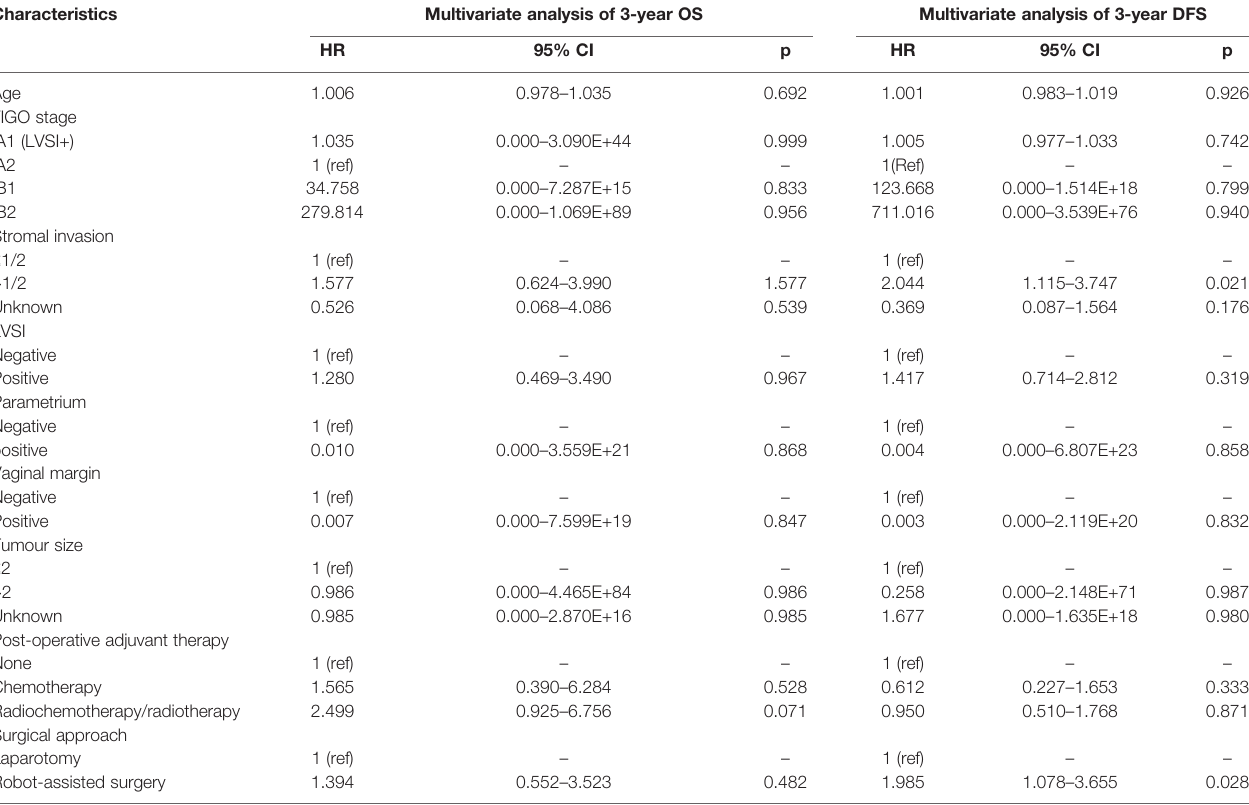
TABLE 2 | Cox multivariate analysis of the relationship between the surgical approach and OS and DFS in cervical cancer. Characteristics Multivariate analysis of 3-year